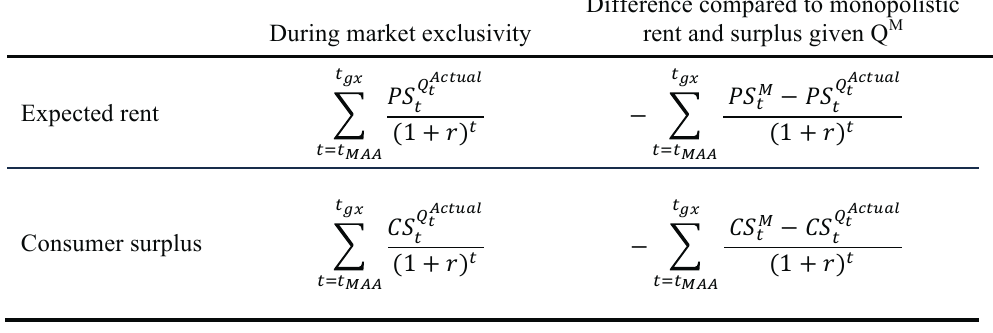
During market exclusivity